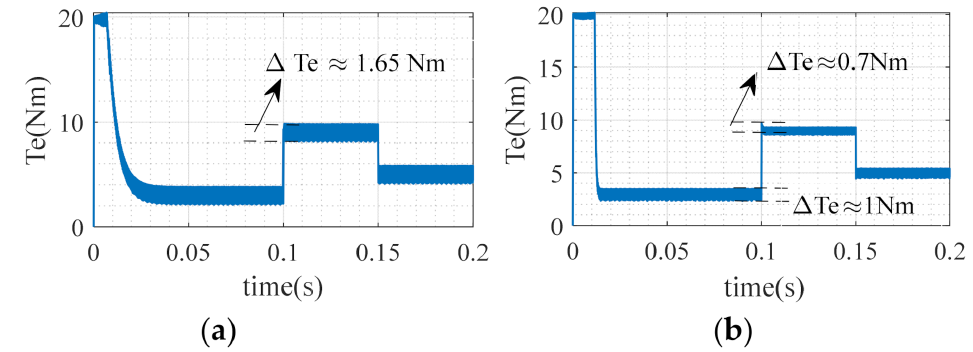
Figure 5. Torque response: ( a ) SMC system with the FPRL; ( b ) SMC system with the IPRL.